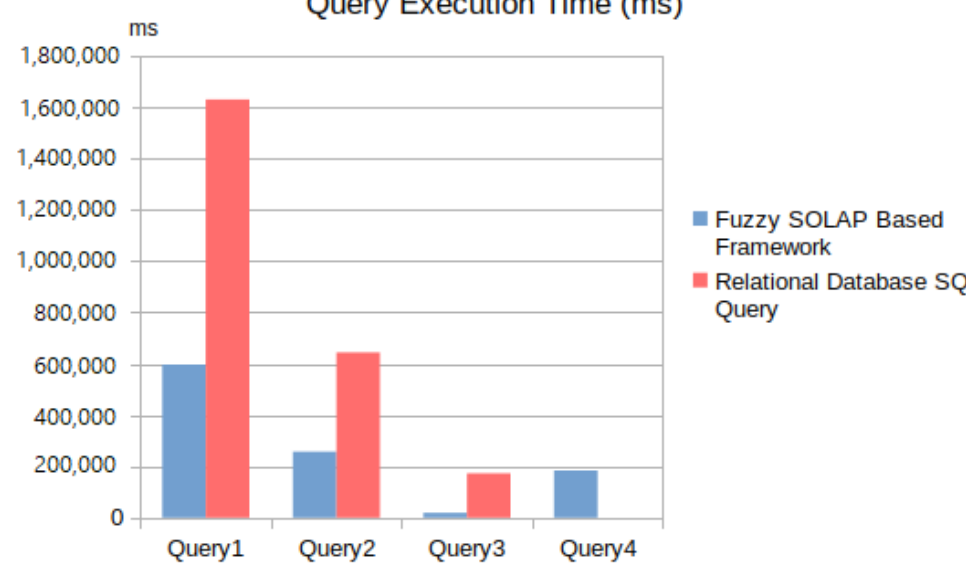
Figure 23. Execution times of FSOLAP and relational database SQL